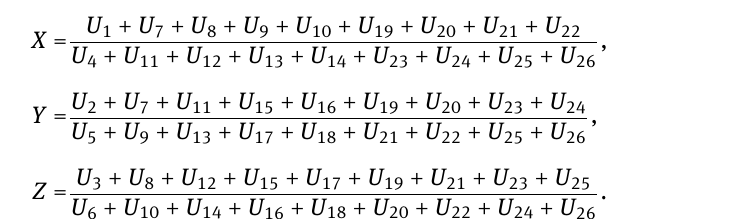
1, 2, ..., 26 are independent variables with U the following